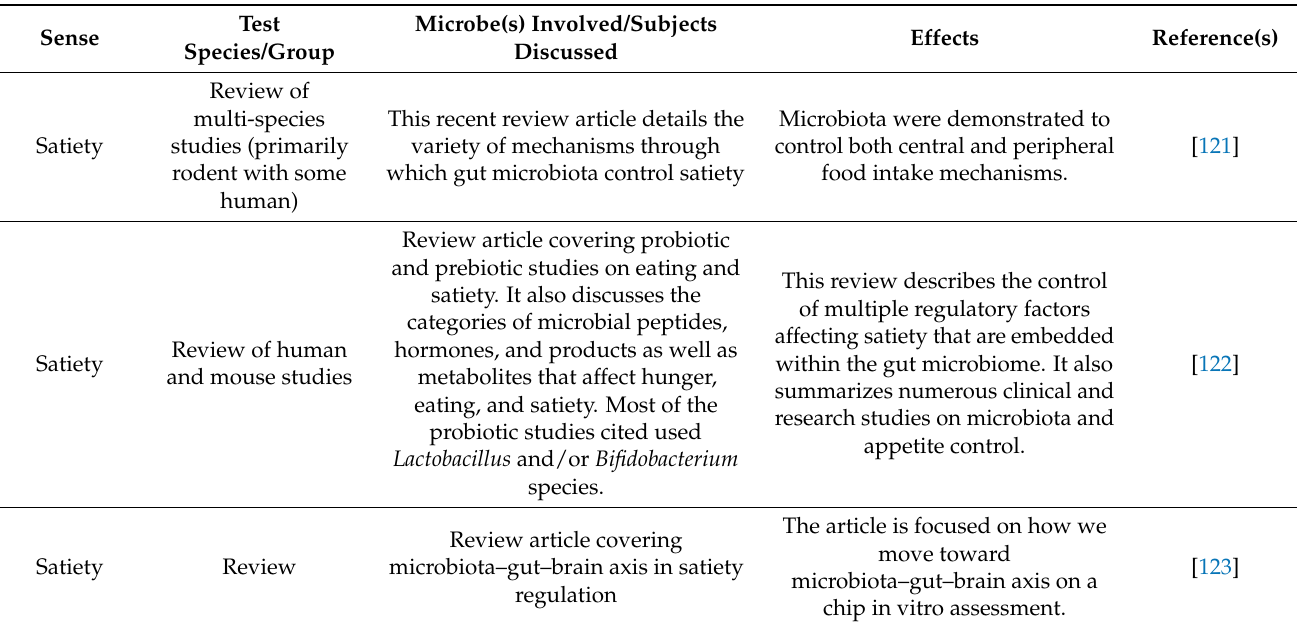
Table 4. The Role of Microbiota in